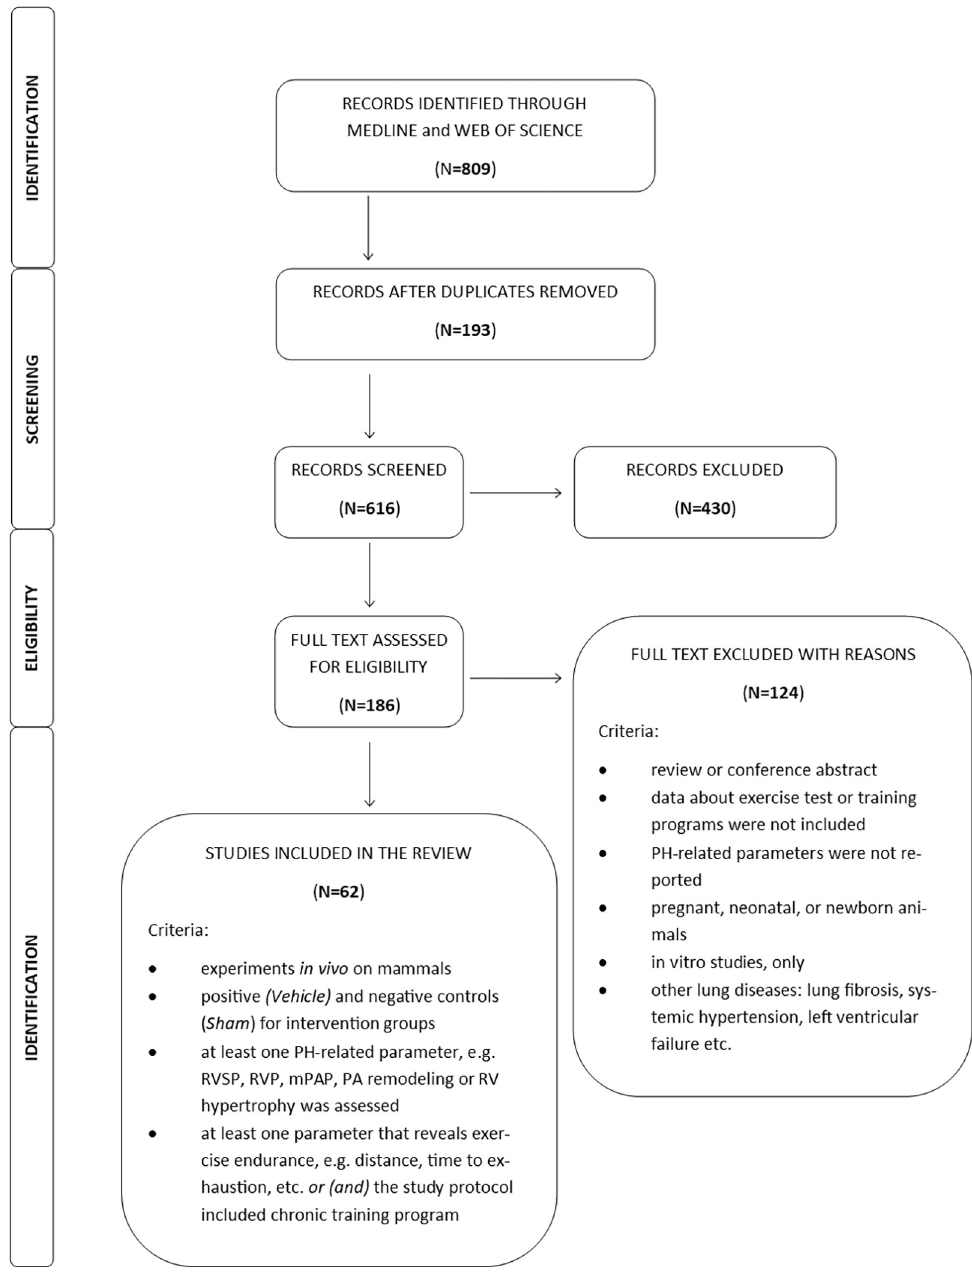
Fig 1. PRISMA flow diagram of the search